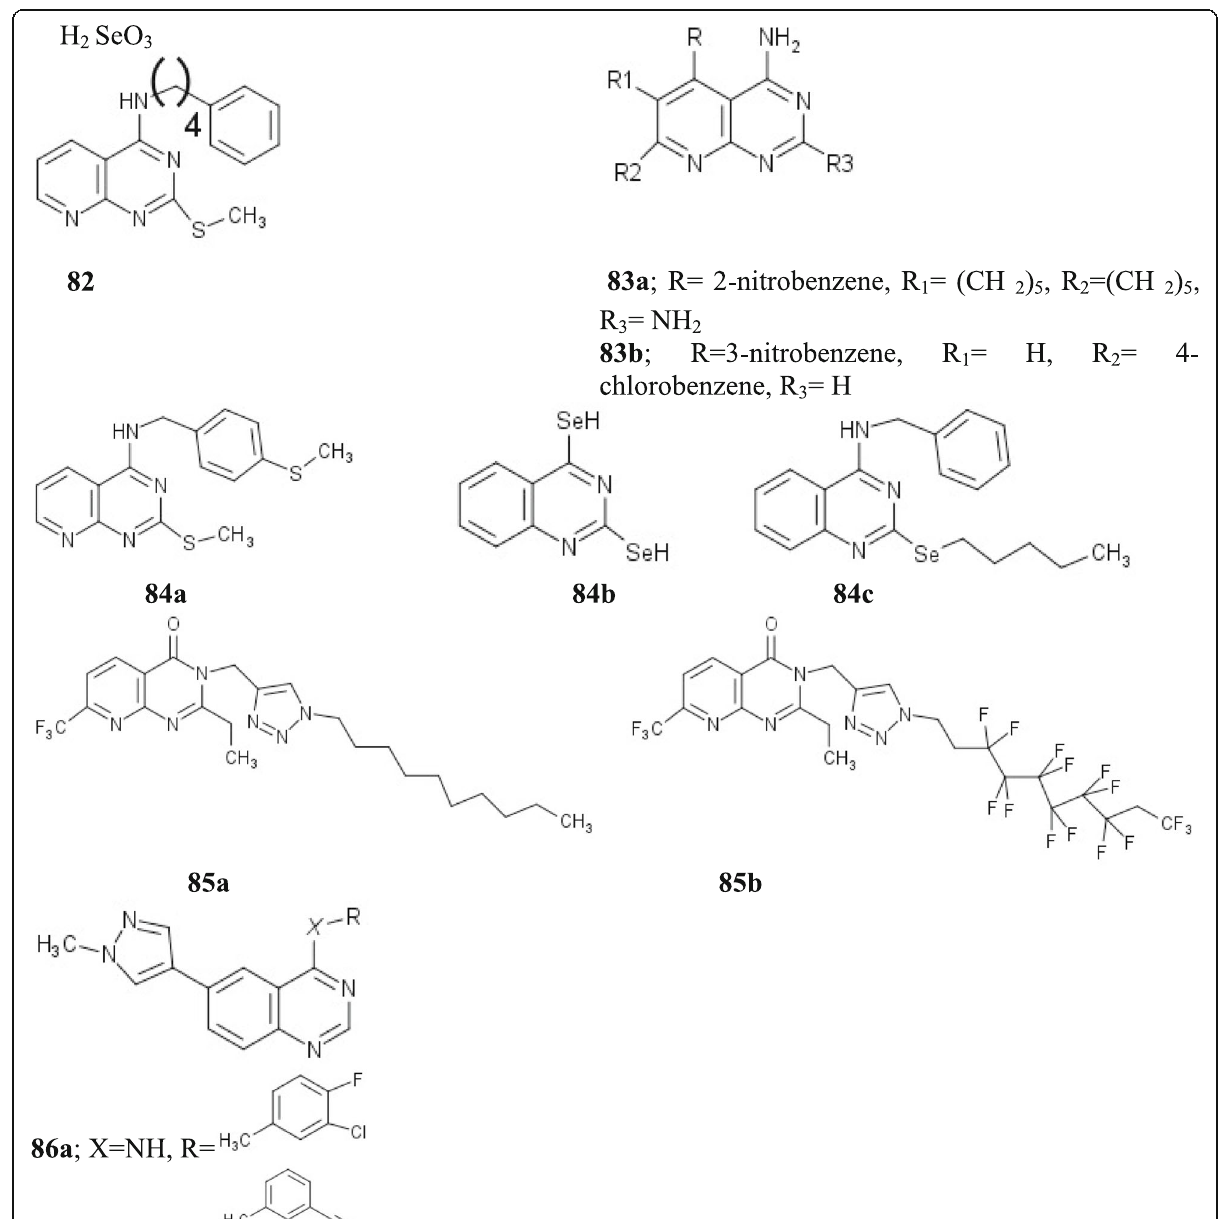
Fig. 28 Chemical structures of pyrido pyrimidine